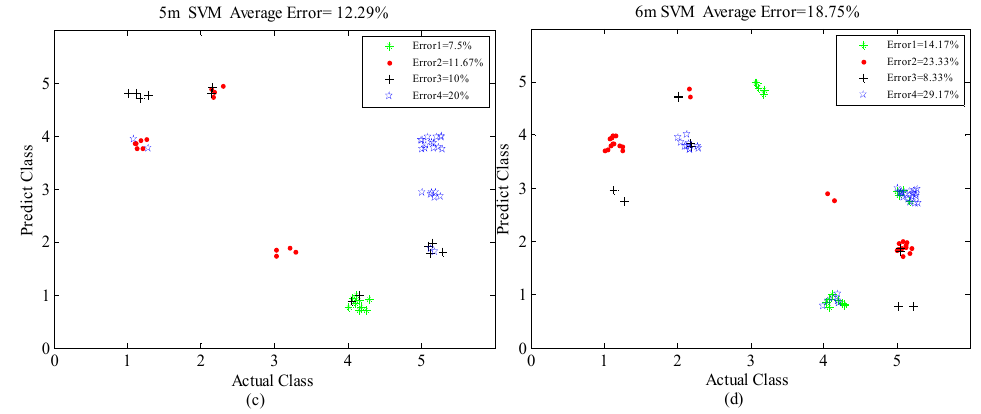
Figure 13. Four-fold cross-validation error distributions of proposed method at different positions: ( a ) 3 m, ( b ) 4 m, ( c ) 5 m, and ( d ) 6 m.